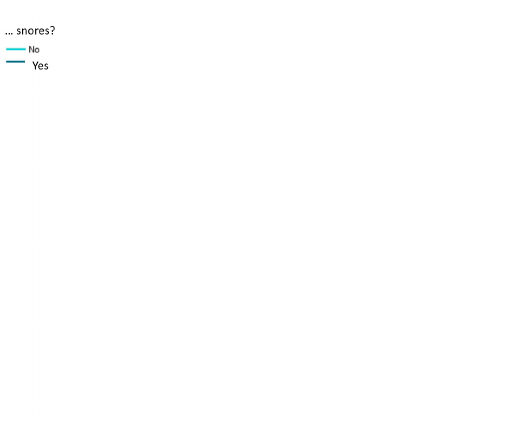
Figure 2. Mean values of the index for the combinations of both factors. When the level of risk is low or moderate, the dmft index is similar between occasional snorers and other children. However, if the level of risk is high, occasional snorers raise the index strongly.